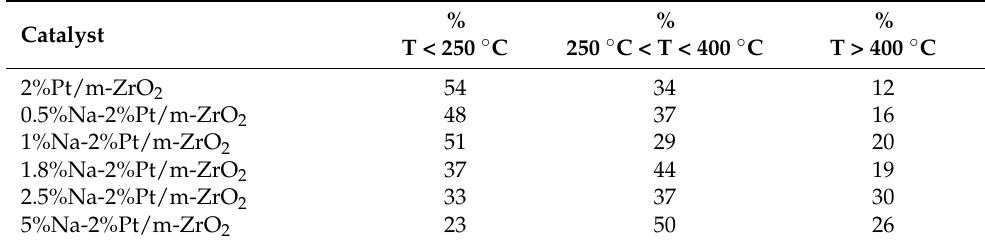
Table 3. Results of fitting CO 2 TPD profiles with Gaussian peaks. Gaussian peak area percentages having maxima within various temperature ranges are shown.